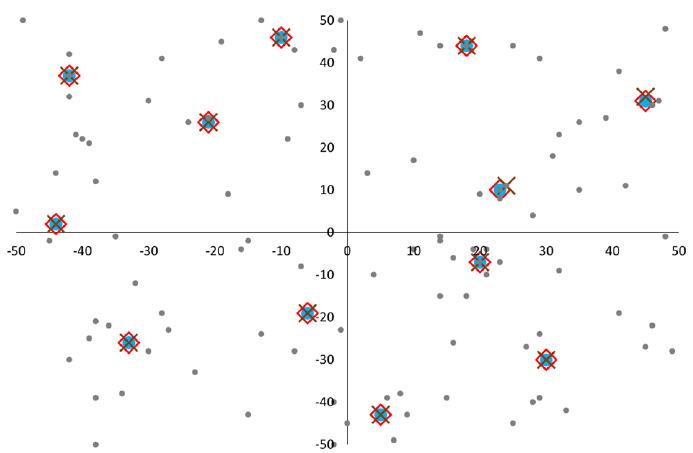
Figure 3. Optimal charging station deployment for the case of 12 stations and different initial station distributions: center placement (brown color), symmetrical placement (red color), random placement (blue color), demand points (grey color).